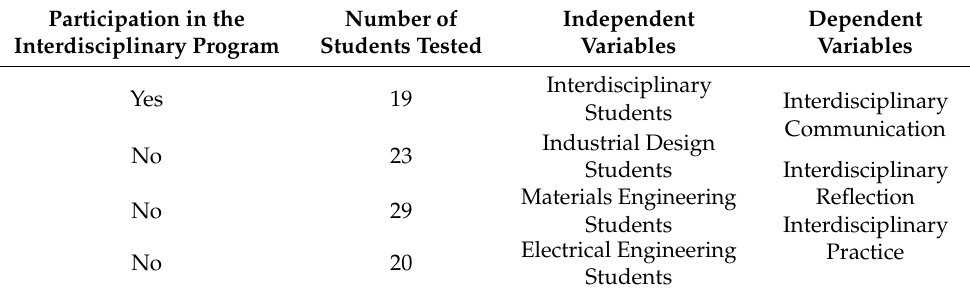
Table 3. Measurement Variables and Number of Students